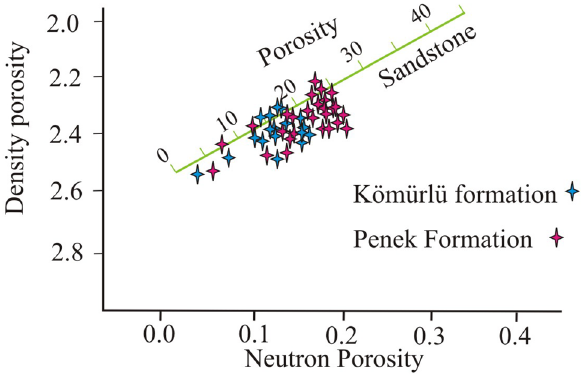
Fig. 13 Density–neutron porosity cross-plot. This graphic gives total porosity values. A single well; depth: the Kömürlü formation: 2348– 2380 m, the Penek Formation: 3060–3100